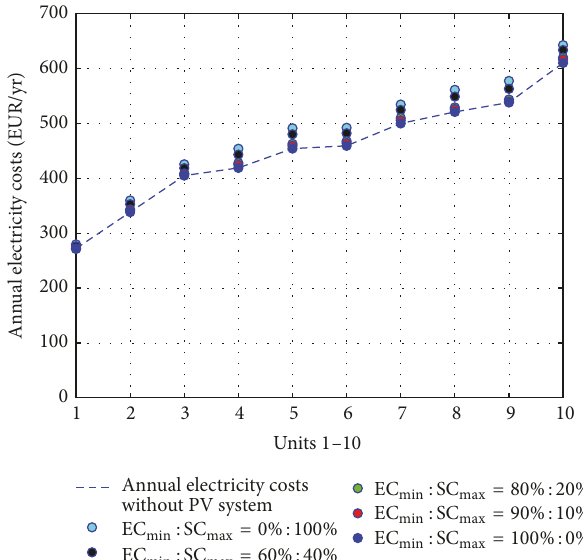
Figure6:Austrianretailelectricityprices:optimalPVpeakcapacity installed and remaining electricity consumption from the